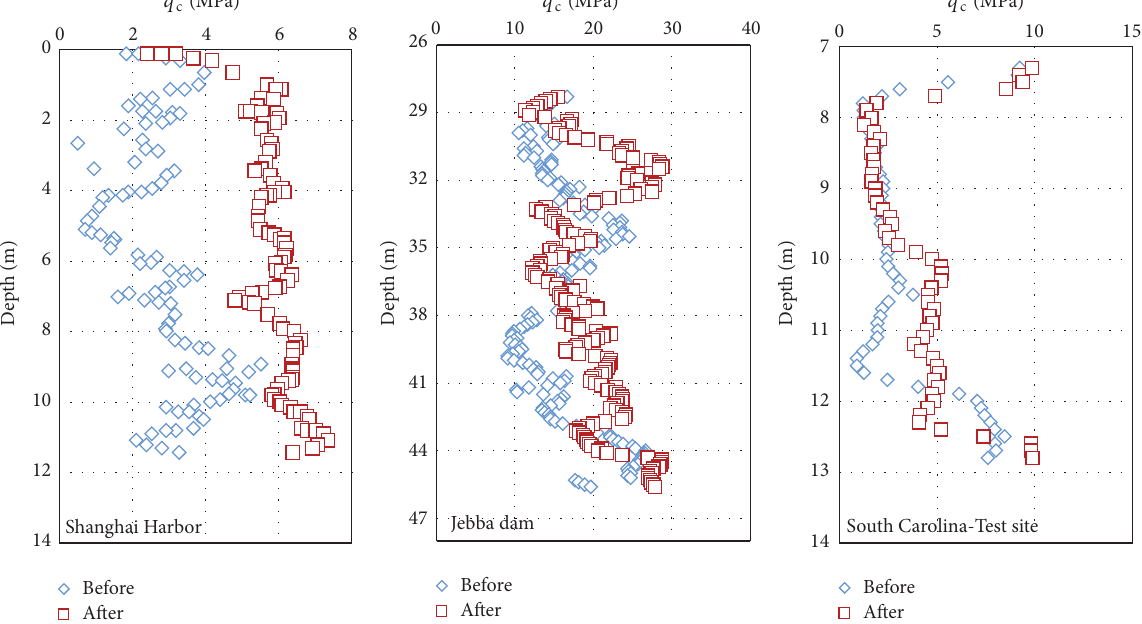
Figure 14: CPT records before and after EC in some sites in the